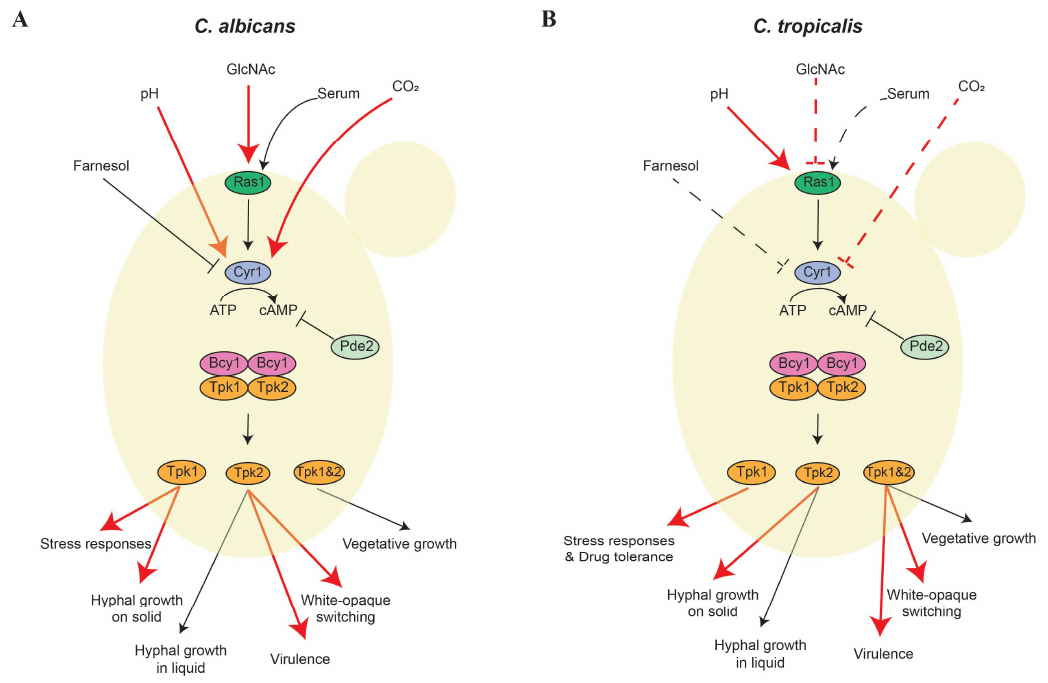
Figure 1. Regulatory models of the cyclic adenosine monophosphate/protein kinase A (cAMP/PKA) signaling pathway in C. albicans and C. tropicalis . Environmental cues activate cAMP/PKA in C. albicans ( A ) and C. tropicalis ( B ). Upon directly sensing environmental cues or being activated by Ras1, Cyr1 converts ATP to cAMP to bind the regulatory subunits of PKA (Bcy1) and liberate the catalytic subunits (Tpk1 and Tpk2). CaTpk1 is required for responding to stress (e.g., oxidative, osmotic, and thermal stressors), while CtTpk1 controls cell wall integrity and drug tolerance. In C. albicans , Tpk1 contributes to hyphal growth on solid media and Tpk2 is involved in hyphal growth in liquid media. In contrast, only Tpk2 contributes to hyphal growth on solid or in liquid media in C. tropicalis . In both species, Tpk1 and Tpk2 have redundant roles in vegetative growth. Furthermore, CtTpk1 and CtTpk2 share redundant functions in white-opaque switching and virulence, but in C. albicans , these two phenotypes are only controlled by Tpk2. GlcNAc induces both hyphal growth and white-opaque switching in C. albicans . In contrast, GlcNAc inhibits hyphal growth but promotes white-opaque switching in C. tropicalis . CO 2 induces white-opaque switching in C. albicans , but inhibits the same transition in C. tropicalis . Environmental pH regulates hyphal growth via Cyr1 in C. albicans . In contrast, environmental pH controls white-opaque switching through Ras1-cAMP/PKA in C. tropicalis . Red lines and arrows indicate differences and dash lines represent these interactions have not been characterized between C. albicans and C. tropicalis